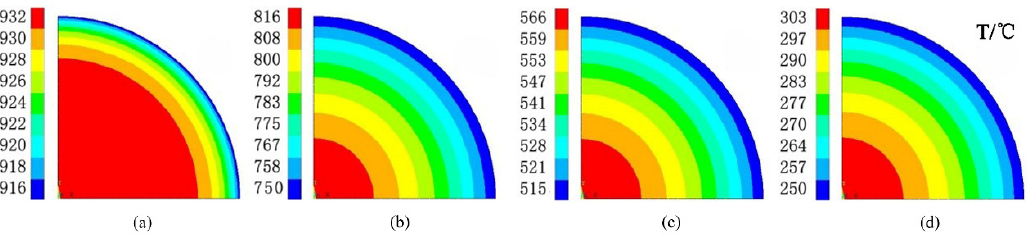
Figure 4. Temperature distribution contour at different time (a) 0.1s, (b) 5s, (c) 15s, (d)